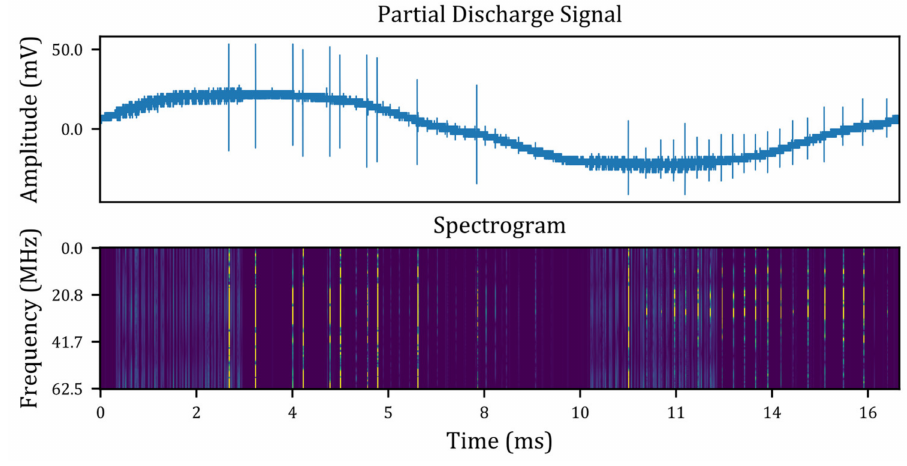
Figure 3. Example of a partial discharge signal in time domain ( top ) and its spectrogram ( bottom